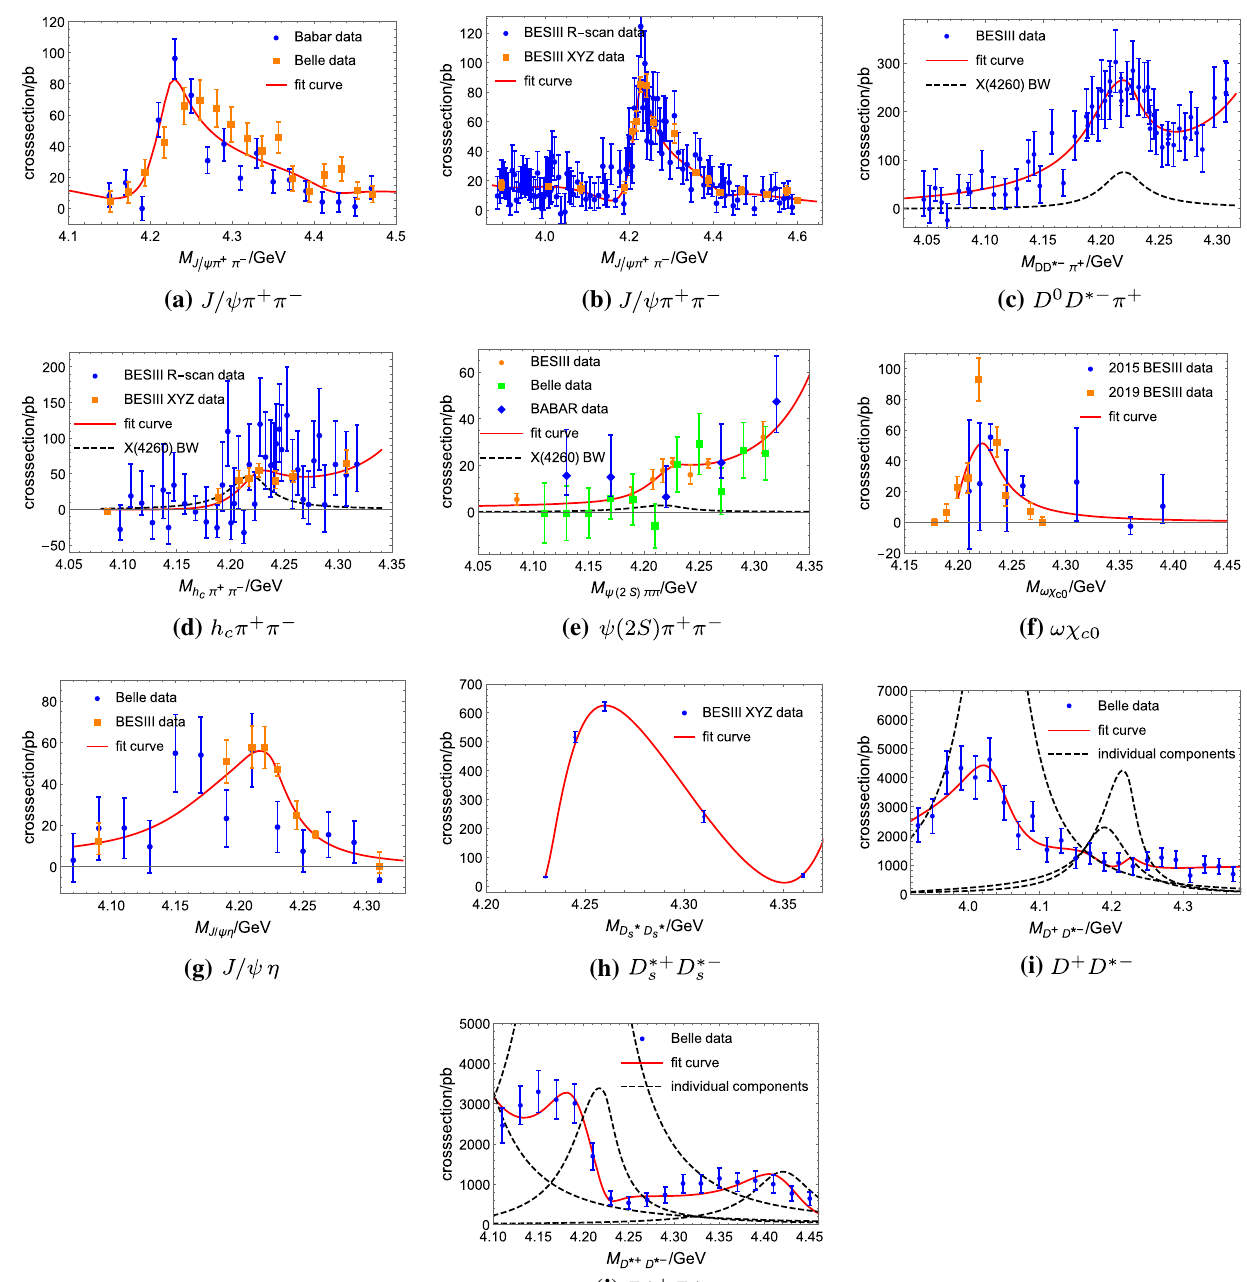
Fig. 3 The results of the fit with D ∗+ s D ∗− s cross section data. The solid curves in all subgrpaphs are the projections from the best fit: a and b fit to the cross section of J /ψπ + π − ; c fit to D 0 D ∗− π + data, where the dashed black one represents X ( 4260 ) components; d fit to h c π + π − data, where the dashed black one indicates X ( 4260 ) components; e fit to ψ( 2 S )π + π − data, where the dashed black one describes X ( 4260 ) components; f fit to ωχ c 0 cross section data, and we do not fit the two